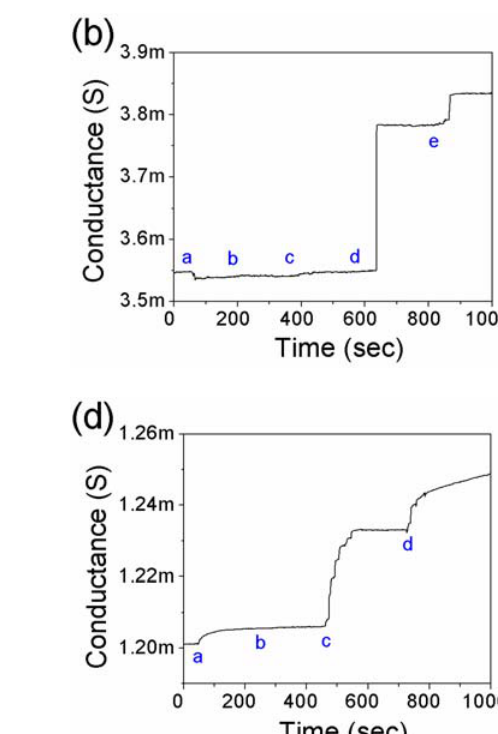
Figure 3. Single PANI nanowire biosensor chips integrated with microfluidic channel present the lowest detection of cardiac biomarkers. ( a ) Detection of Myo (a: